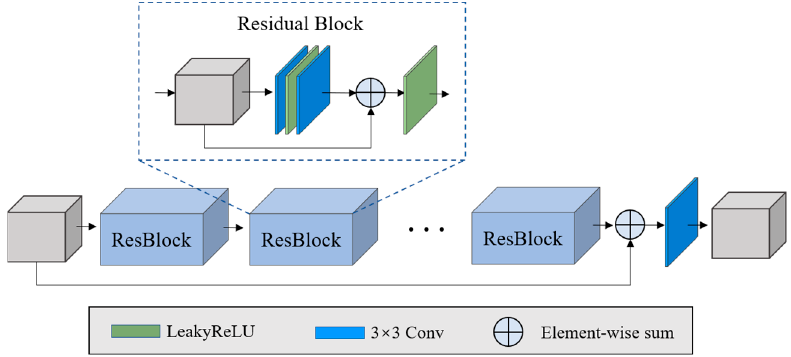
Figure 2. Illustration of the feature extraction sub-network.